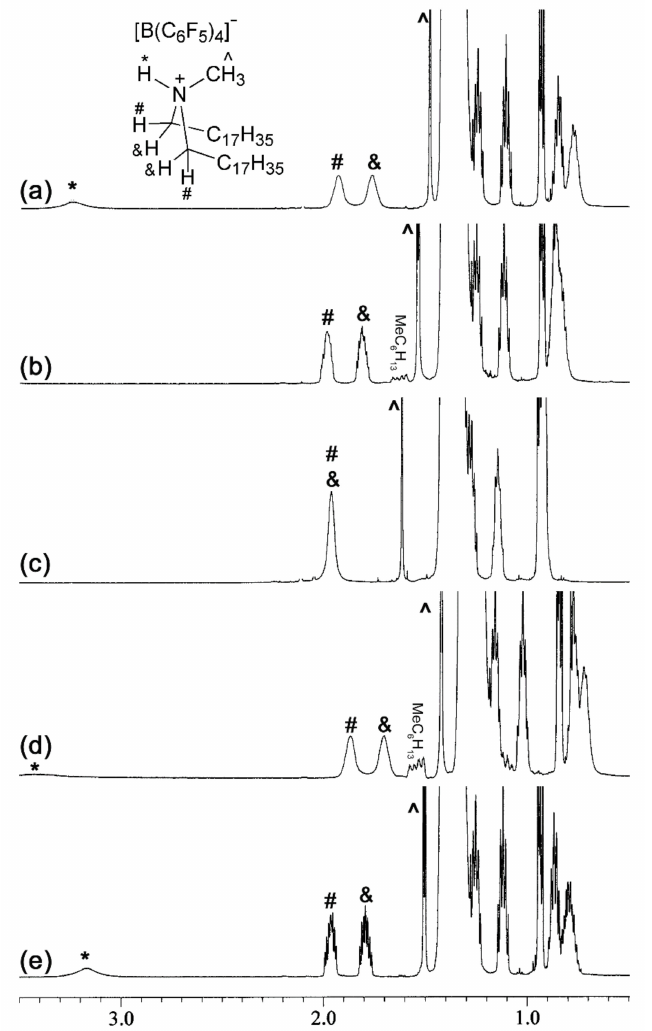
Figure 1. 1 H NMR spectra (recorded in C 6 D 6 ) of [Me(C 18 H 37 ) 2 N-H] + [B(C 6 F 5 ) 4 ] − prepared by the reactions Li + [B(C 6 F 5 ) 4 ] − + [Me(C 18 H 37 ) 2 N-H] + [Cl] − (removal of LiCl with water) ( a ), Li + [B(C 6 F 5 ) 4 ] − + [Me(C 18 H 37 ) 2 N-H] + [Cl] − (removal of LiCl by filtration) ( b ), K + [B(C 6 F 5 ) 4 ] − + [Me(C 18 H 37 ) 2 N- H] + [Cl] − (removal of KCl with water) ( c ), K + [B(C 6 F 5 ) 4 ] − + [Me(C 18 H 37 ) 2 N-H] + [Cl] − (removal of KCl by filtration) ( d ), and [PhN(Me) 2 -H] + [B(C 6 F 5 ) 4 ] − + Me(C 18 H 37 ) 2 N ( e ). Signals marked with *, #, &, and ˆ characters correspond to protons marked with those characters in the